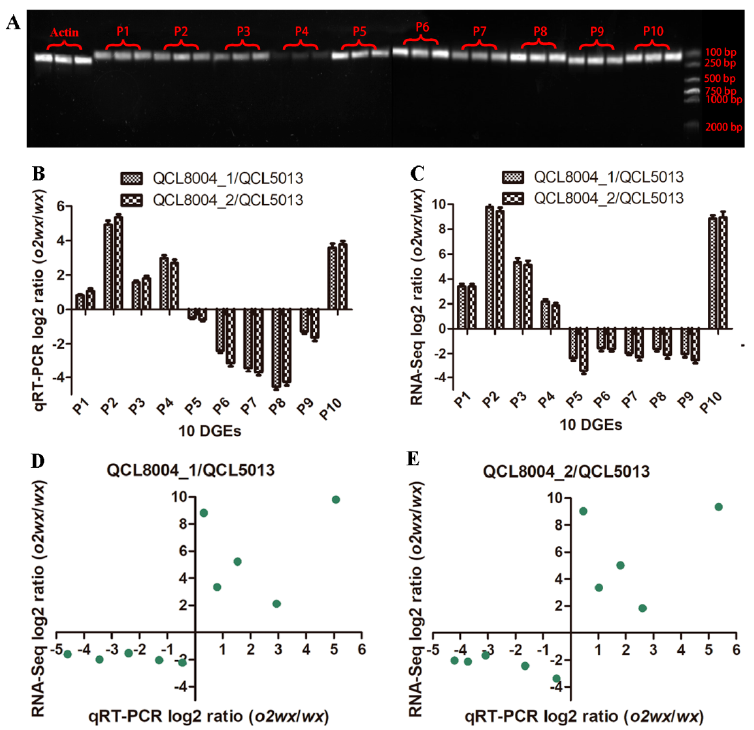
Figure 7. ( A ) The electrophoresis pattern of 10 DGEs by qRT-PCR. ( B ) The qRT-PCR log2 ratio ( o2wx / wx ). ( C ) The RNA-Seq log2 ratio ( o2wx / wx ) of 10 DGEs. ( D ) The qRT-PCR validation of 10 DGEs identified by RNA-seq, Pearson’s r = 0.8760. ( E ) The qRT-PCR validation of 10 DGEs